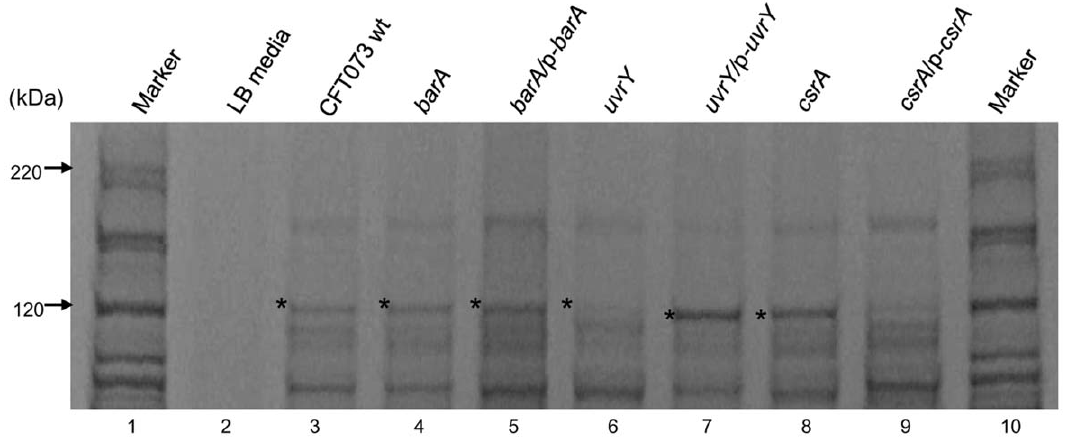
Figure 4. Protein profiles of wild type and mutant bacteria supernatant. Secreted supernatants were filter purified and separated on 4–20% SDS-PAGE gel and stained with Coomassie blue. Bands of the interest were incised and subjected to mass spectrometry analysis. Star indicates the location of the hemolysin protein band. The results were representative of three individual experiments. Lanes: 1. protein marker, 2. LB media, 3. CFT073 wt, 4. barA , 5. barA/ p -barA , 6. uvrY , 7. uvrY /p- uvrY , 8. csrA , 9. csrA /p -csrA , 10. protein marker.